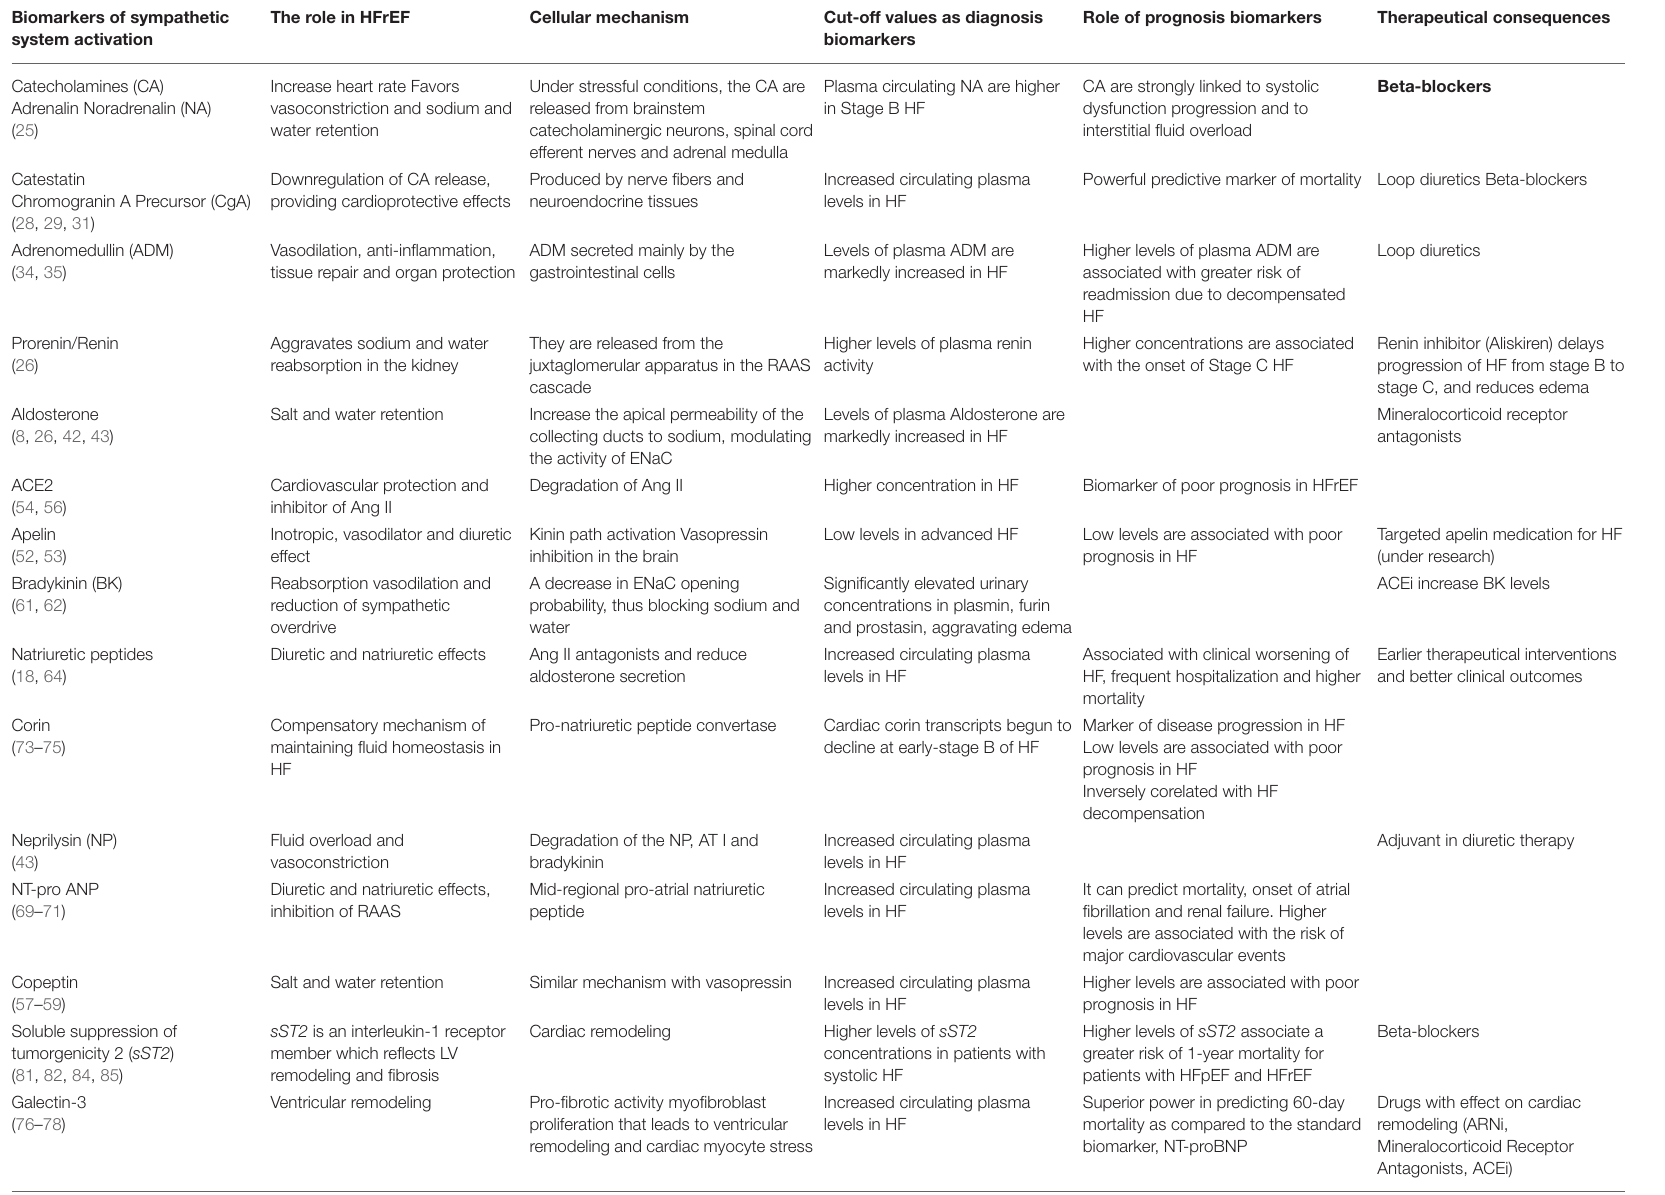
TABLE 1 | Biomarkers with clinical implications for edema in